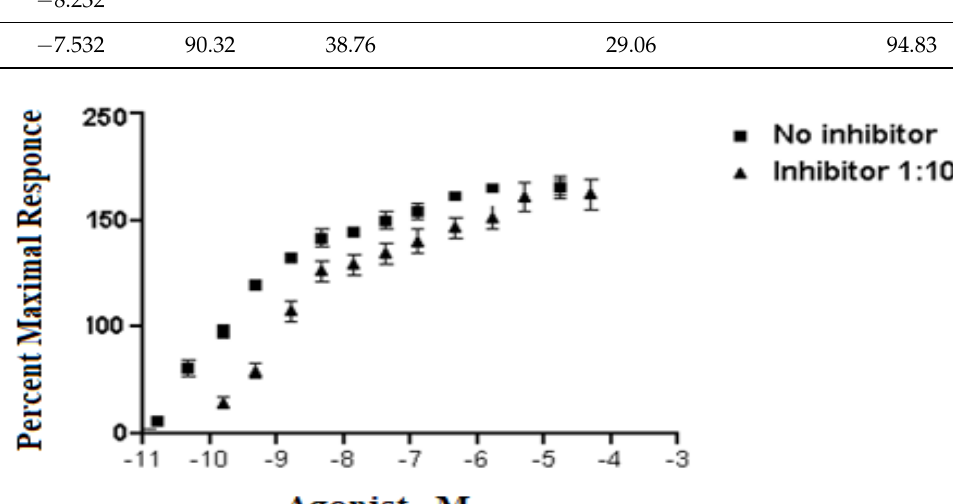
Figure 1. The inhibitory effect curve of P. amygdalus var . amara at various concentrations (5–300 µg/mL).